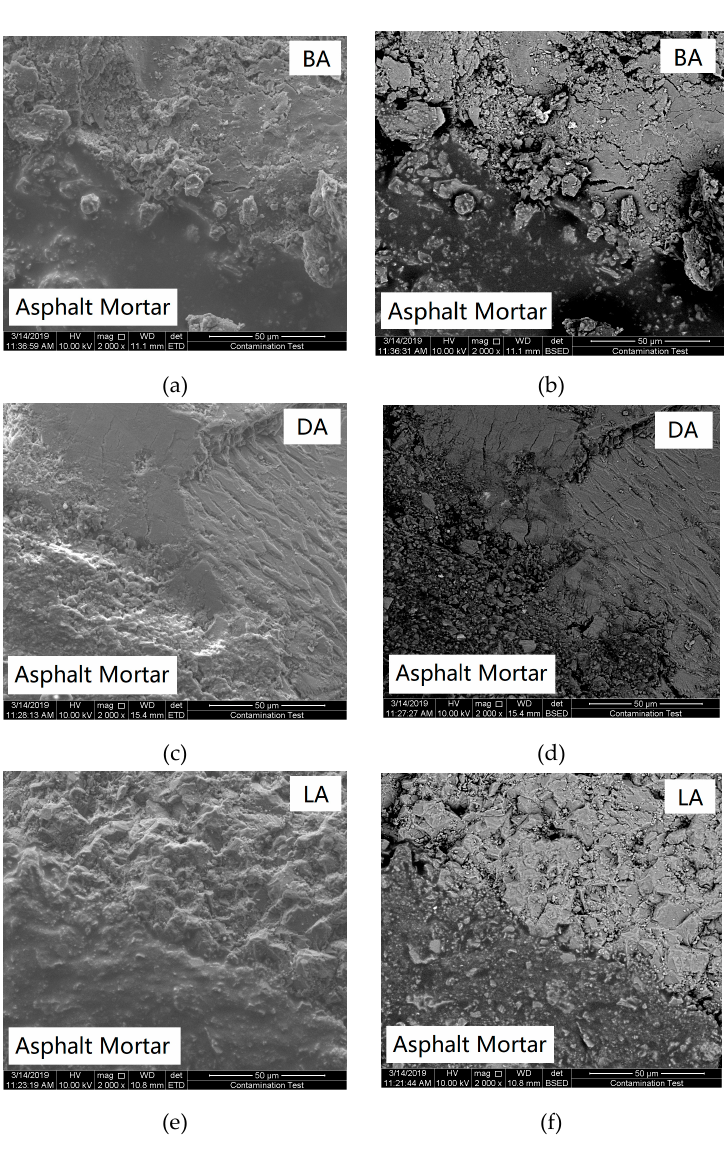
Figure 15. Microstructural states of the interfacial zone. ( a ) BA-SE, ( b ) BA-BSE, ( c ) DA-SE, ( d ) DA-BSE, ( e ) LA-SE, and ( f ) LA-BSE.